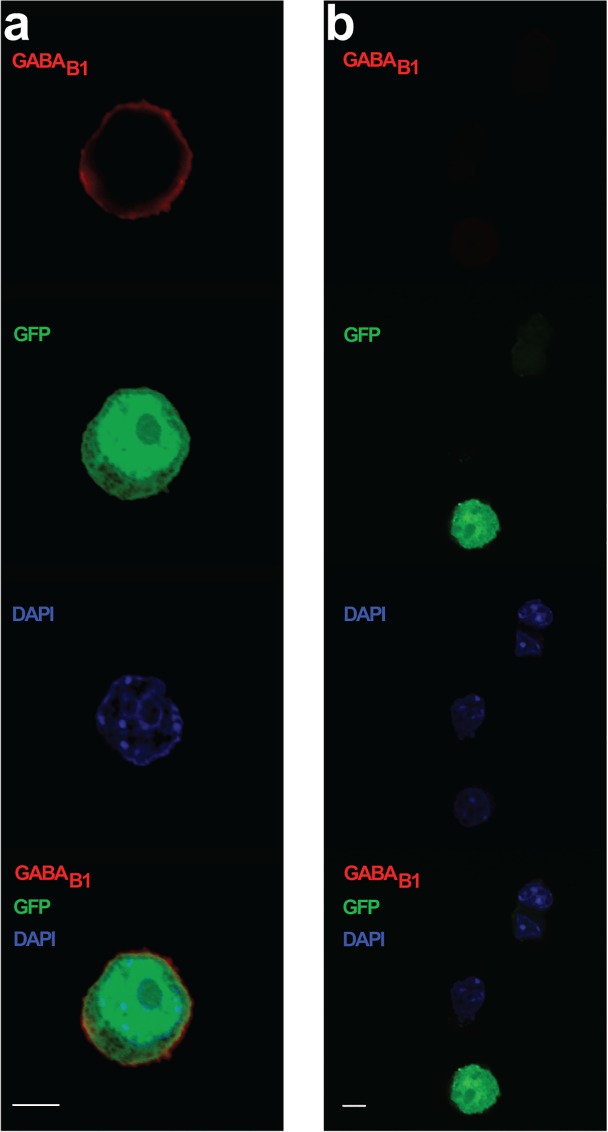
The GABAB1 subunit expresses at the membrane in transfected AtT-20 cells.AtT-20 cells were transfected with both subunits for the GABAB receptor along with GFP (shown in green). Immunohistochemistry was performed for the GABAB1 subunit (red) and cell nuclei were stained with DAPI (blue). a) Magnified image of an isolated cell demonstrating GABAB1 subunit protein at the cell membrane in a GFP positive cell. b) Negative control (no primary antibody for GABAB1). A merged image is shown at the bottom of each column. Scale bars are 5 μm.